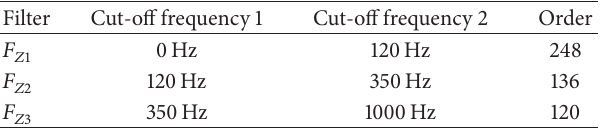
Table 1: Design characteristics of the three digital filters used to decompose the vibration signal. Calculations made for a sampling frequency of